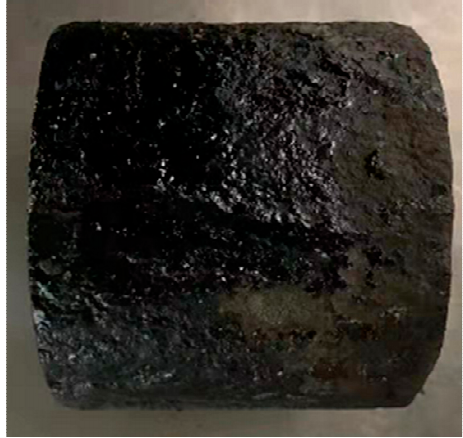
Figure 1. The full diameter core (Core J1) picture. Table 1. Core parameter table.